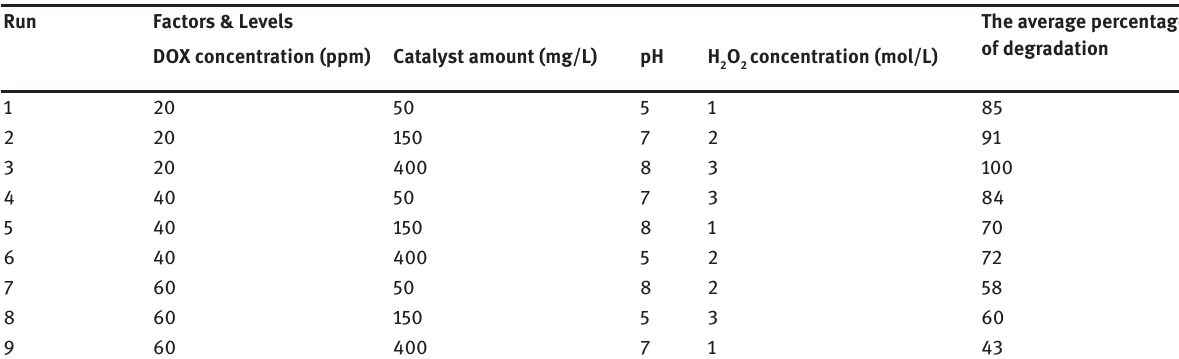
Table 1: Taguchi L Orthogonal Array and Experimental Results for a verage of DOX Degradation 9 Run Factors & Levels The average